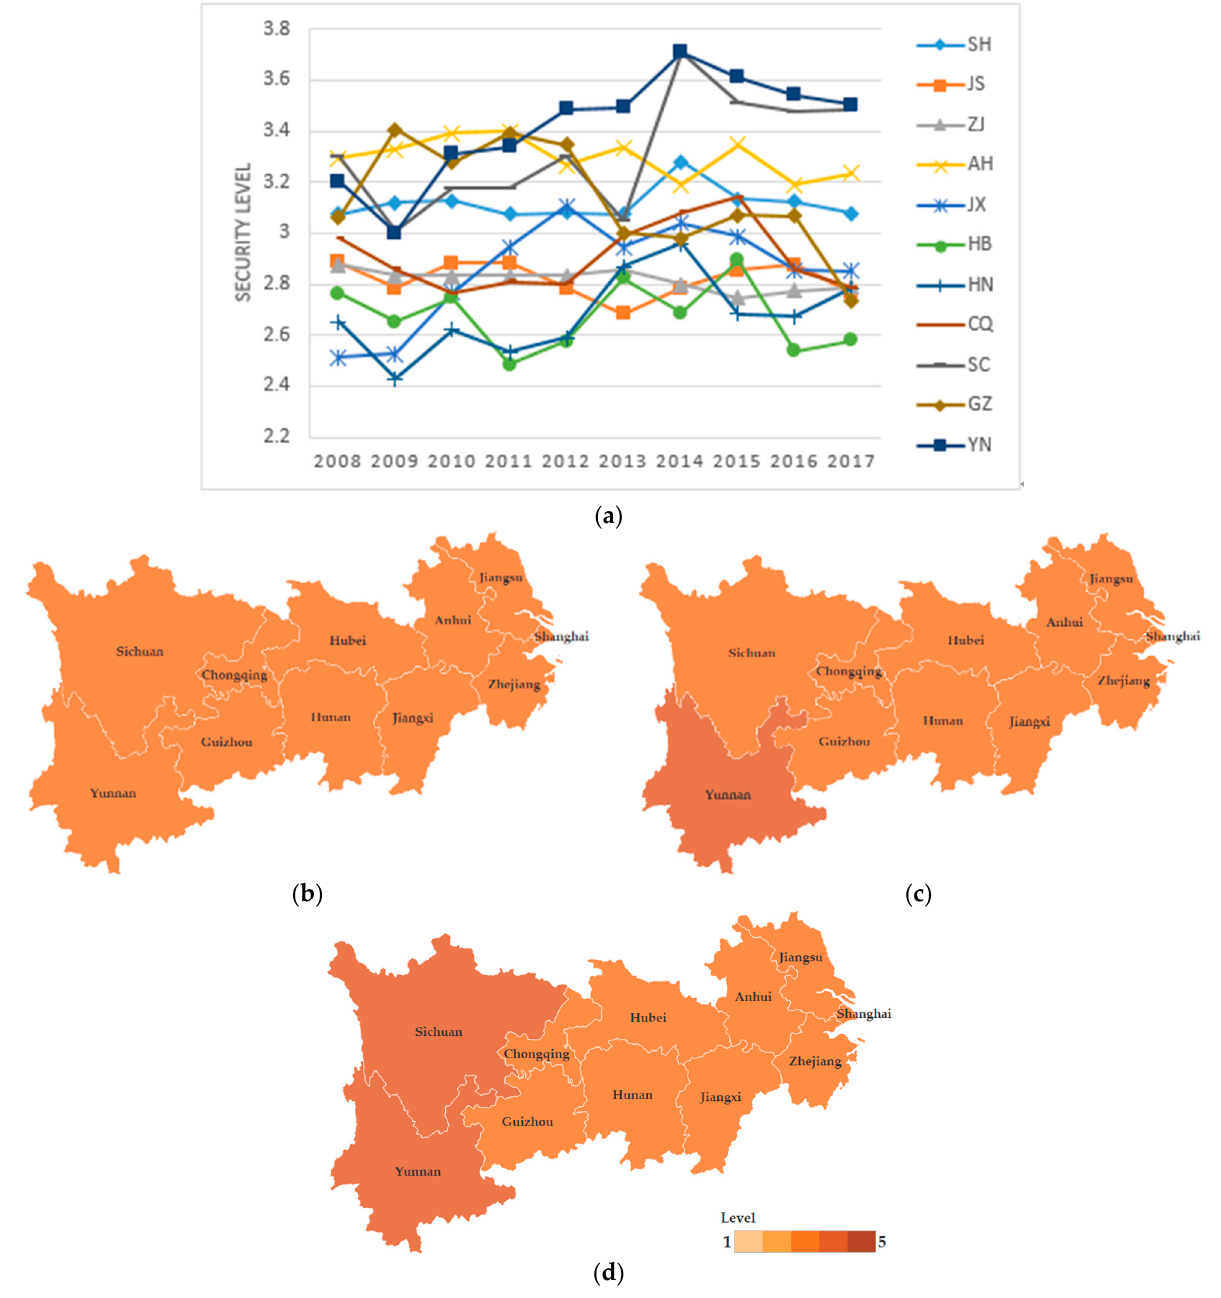
Figure 6. Energy subsystem evaluation results: ( a ) Trend graph of energy subsystem security of each province (municipality) in the Yangtze River Economic Belt during 2008–2017; ( b ) Distribution of energy security in 2008; ( c ) Distribution of energy security in 2012; ( d ) Distribution of energy security in